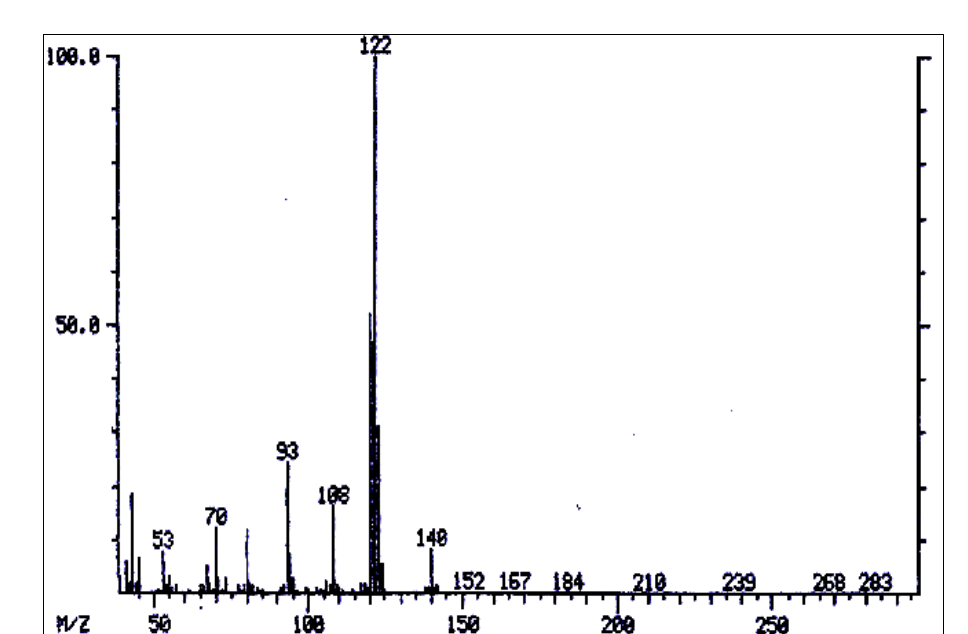
Figure 8. Mass spectrum of